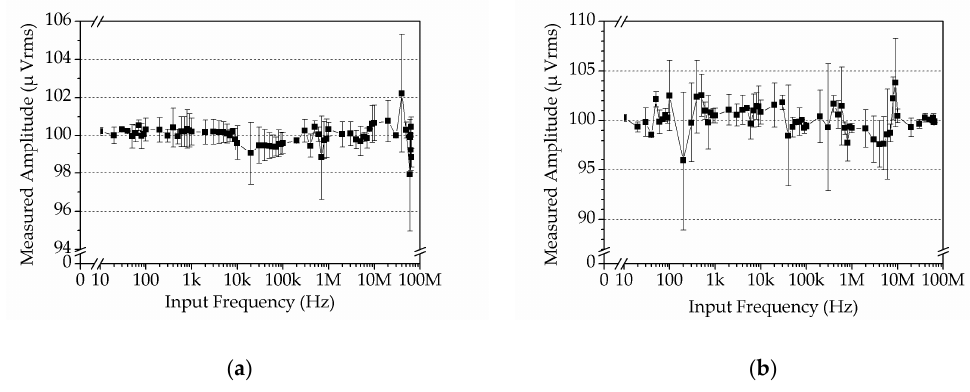
Figure 14. Amplitude–frequency response. ( a ) High SNR measurement. The input signal was a 100 µ Vrms sine wave without white noise. ( b ) Low SNR measurement. The input signal contained a 100 µ Vrms sine wave with 10 mV white